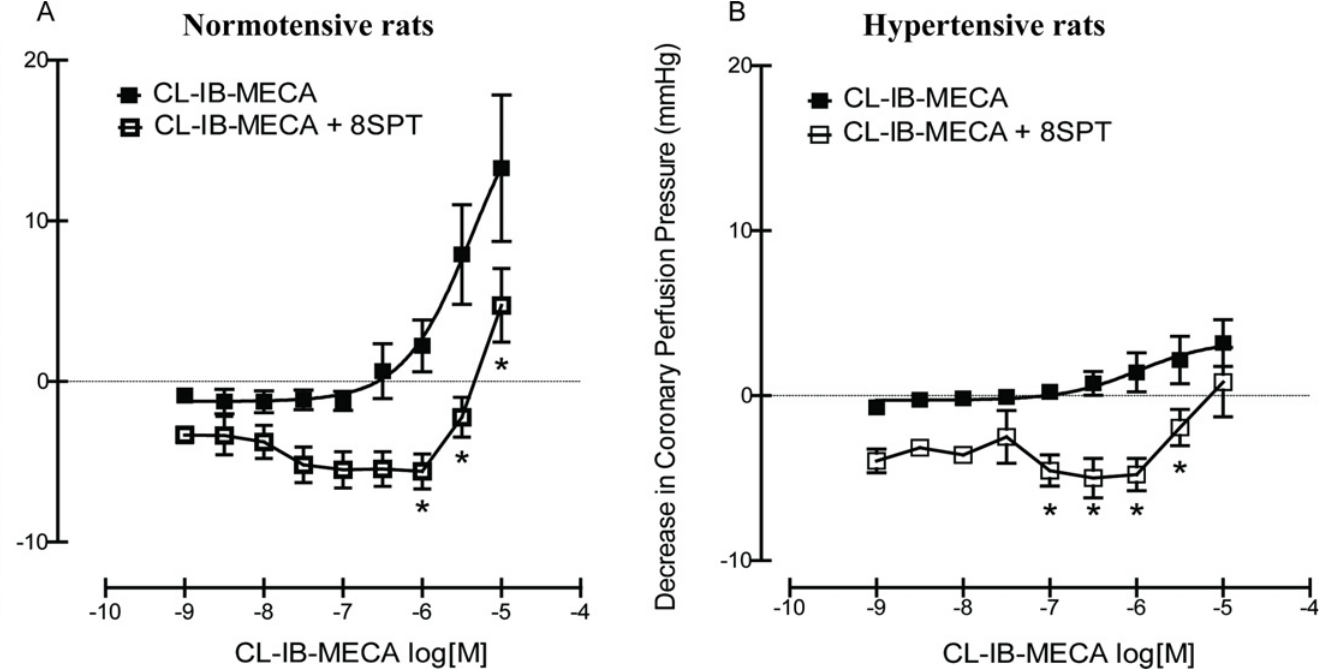
Fig 3. Concentration response curve showing the effects of CL-IB-MECA in the absence and presence of 8SPT (10 -5 M) in (A) normotensive rats and (B) spontaneously hypertensive rats. Concentration response curves to CL-IB-MECA were analysed using nonlinear regression, from which EC 50 values and 95% confidence intervals were also derived. One-way or two-way ANOVA were performed on the data, followed by Tukey ’ s Multiple Comparison Test/ Bonferroni for individual comparisons when significant effects were detected. * denotes statistical significance (p < 0.05) compared to absence of antagonist group.